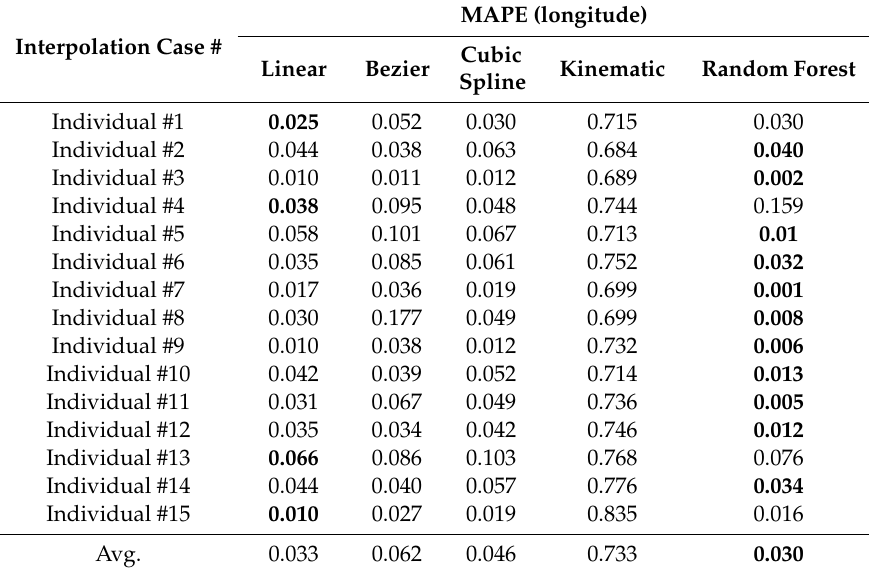
Table 3. Comparison of MAPEs for missing longitude records interpolation.